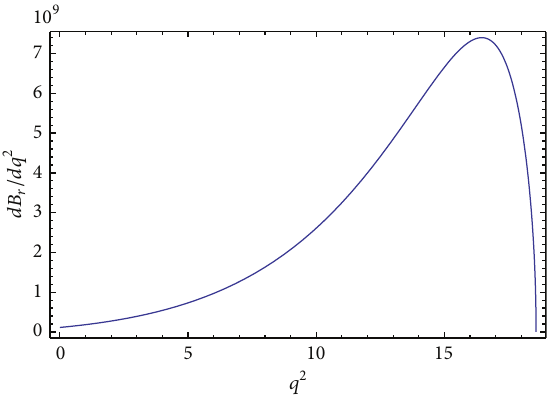
Figure 3: The dependence of the branching ratio on 𝑞 2 for 𝐵 ∗ 𝑐 → 𝜇 + 𝜇 − transitions. 𝐷 𝑠